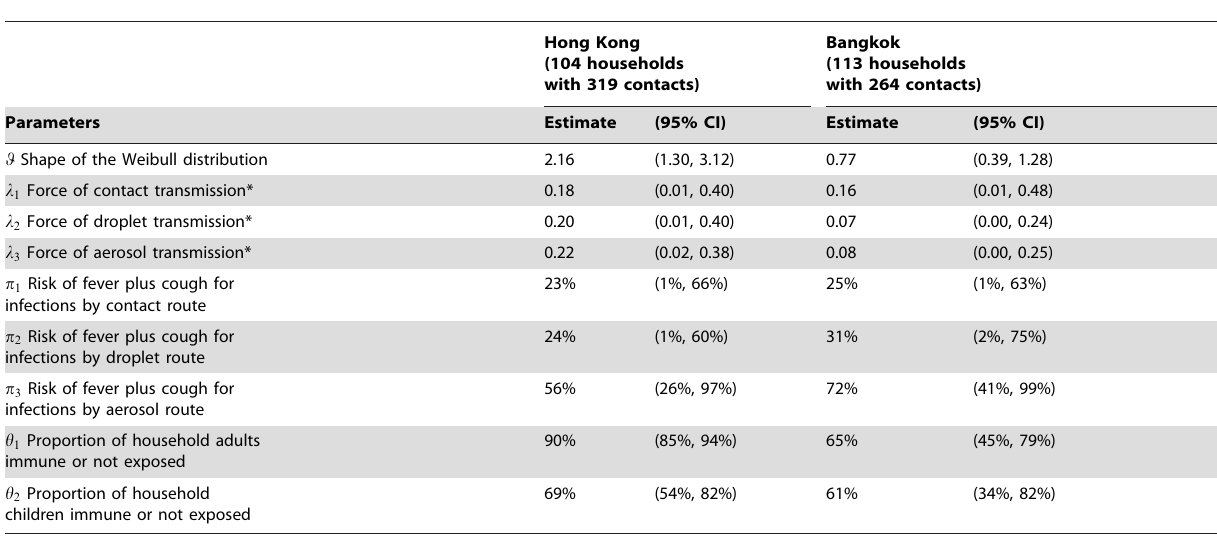
Table 4. Point estimates and 95% credible intervals of model parameters under an exemplar plausible scenario that hand hygiene and surgical face masks reduced contact and droplet transmission respectively by 50% from the time of application of those